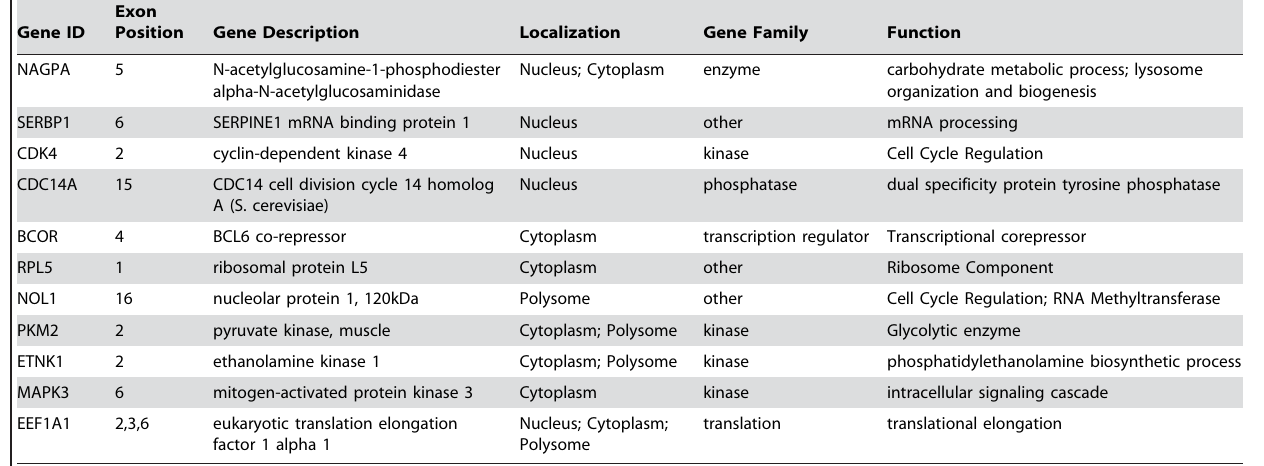
SF2/ASFtargetexonscontainingalternative5 9 splicesites